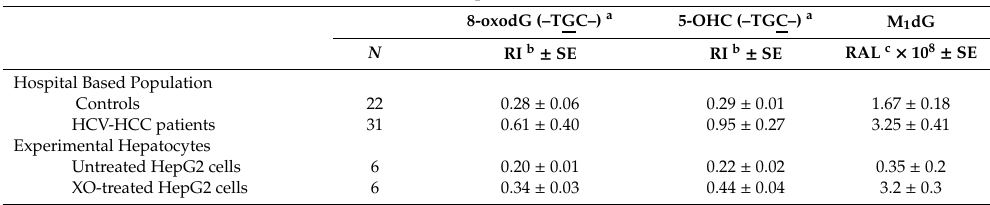
Table 1. Levels of 7-hydro-8-oxo-2 (cid:48) -deoxyguanosine (8-oxodG) and 5-hydroxycytosine (5-OHC) at the codon 176 along the exon 5 sequence of the p53 gene among hepatitis C virus (HCV)-associated hepatocellular carcinoma (HCC) patients and controls, as well as hepatocytes in vitro treated with 0.2mM xanthine plus 5.0mU xanthine oxidase (XO)-treated. Frequency of 3-(2-deoxy- β - d -erythro-pentafuranosyl)pyrimido[1,2- α ]purin-10(3H)-one deoxyguanosine (M 1 dG) are reported. Oxidative Base Lesions at the Codon 176 of the p53 Gene and Generation of M 1 dG in Genomic DNA